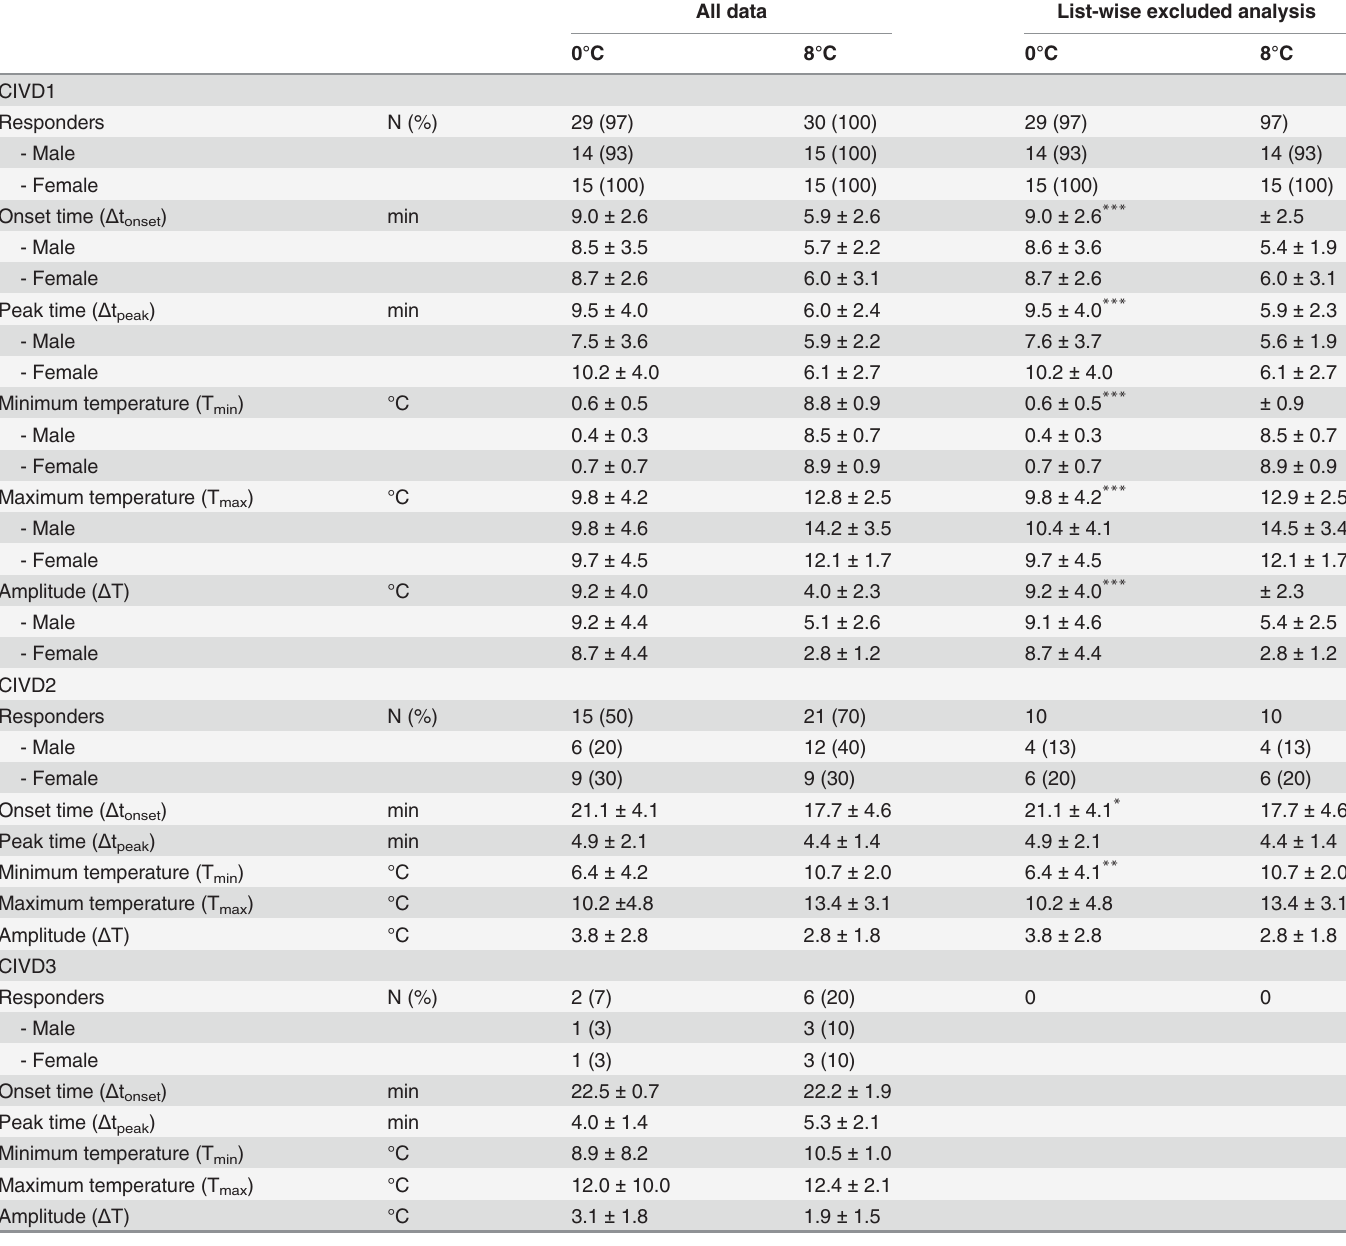
Table 1. Cold-induced vasodilation data during 0 and 8°C water